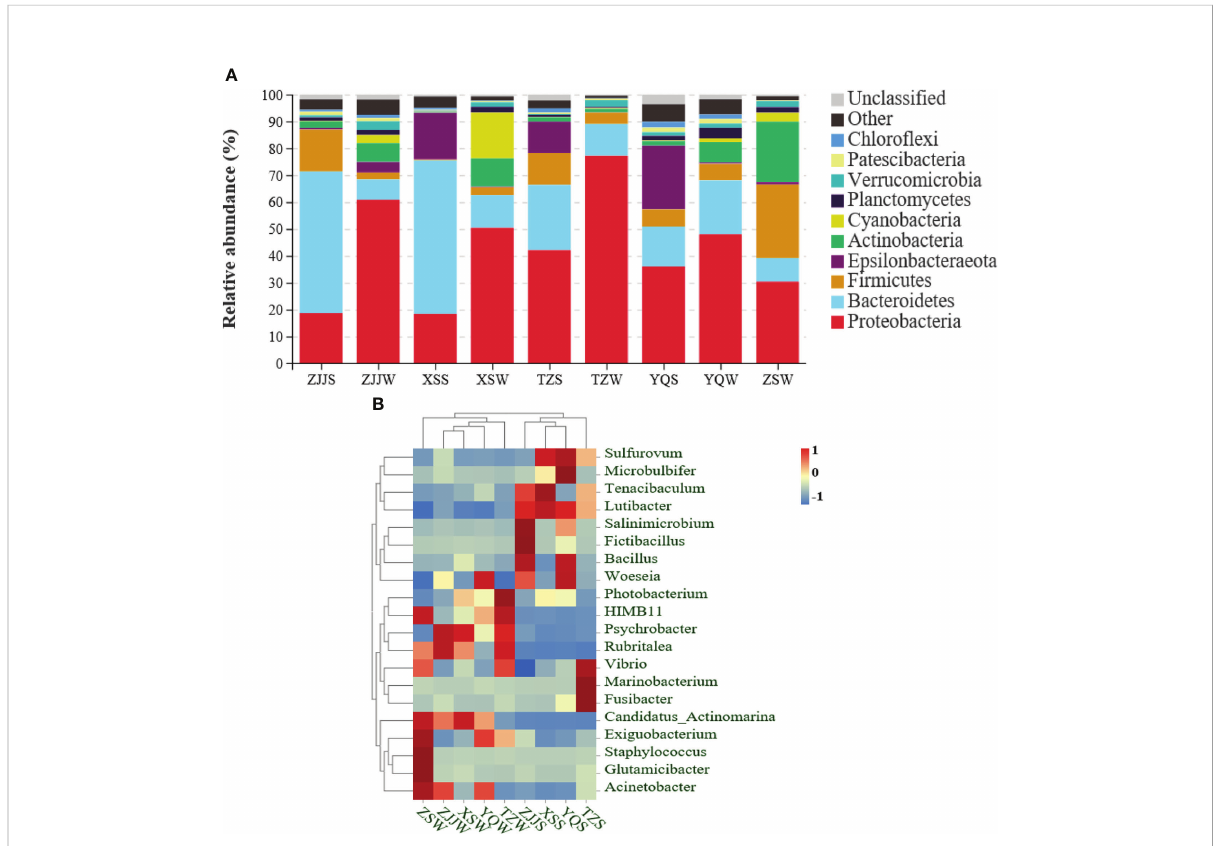
FIGURE 3 Relative abundance of dominant bacterial composition in each group. (A) Stacked bar plot analysis of bacterial abundance at the phylum level. The “ Other ” represents all other phyla outside the 10 listed phyla. (B) Heatmap analysis of the relative abundance of the top 20 genera. The relative abundance of each bacterial genus is depicted by the colour intensity ranged from 1 to